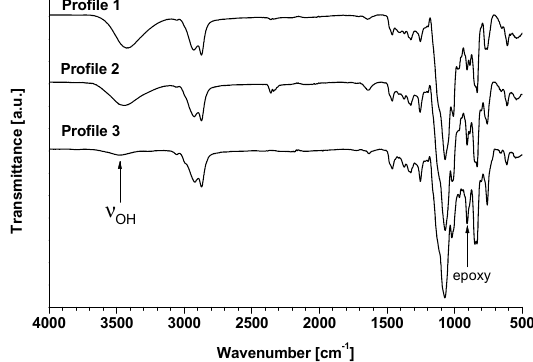
Figure 2. FT-IR spectra of oligo-isosorbide glycidyl ethers.